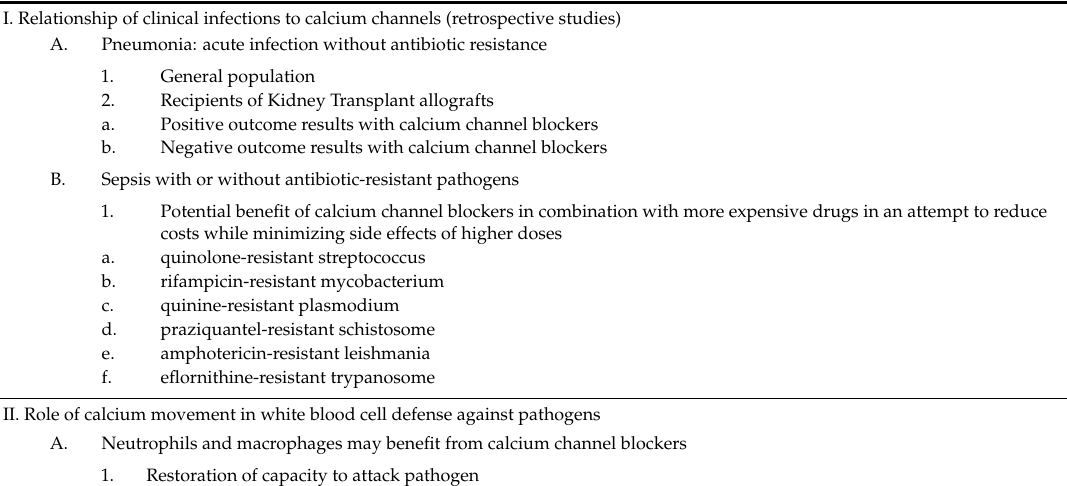
Table 2. Calcium Ion Channels and hypothetical role in expression of